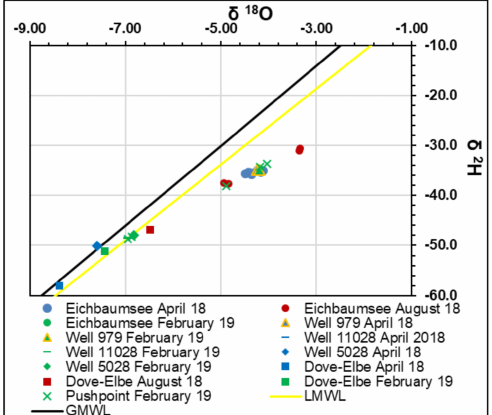
Figure 13. δ 18 O and δ 2 H of lake water, the Dove-Elbe, groundwater, and push-point samples, the global Meteoric Water Line (GMWL), and the Local Meteoric Water Line (LMWL). Lake water and groundwater from well 979 plot close to each other suggesting an exchange between this aquifer and the